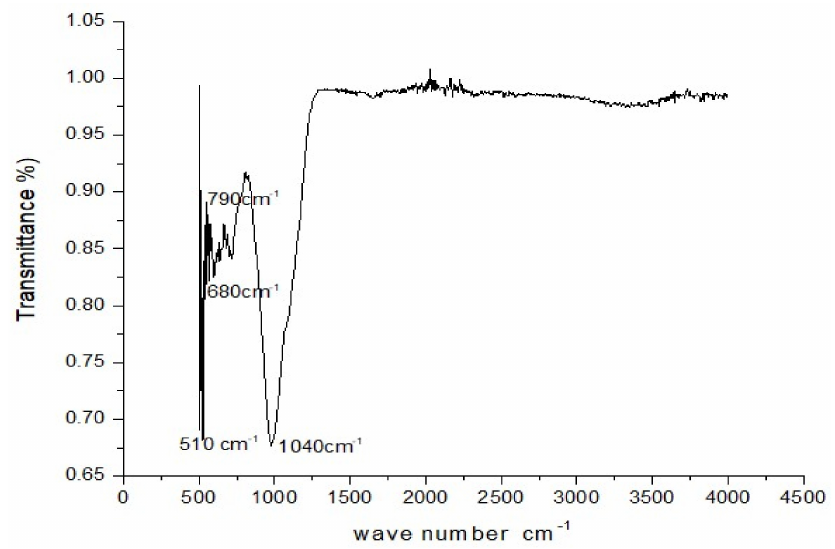
Figure 12. Infrared spectra of calcinized composite of bentonite and sodium